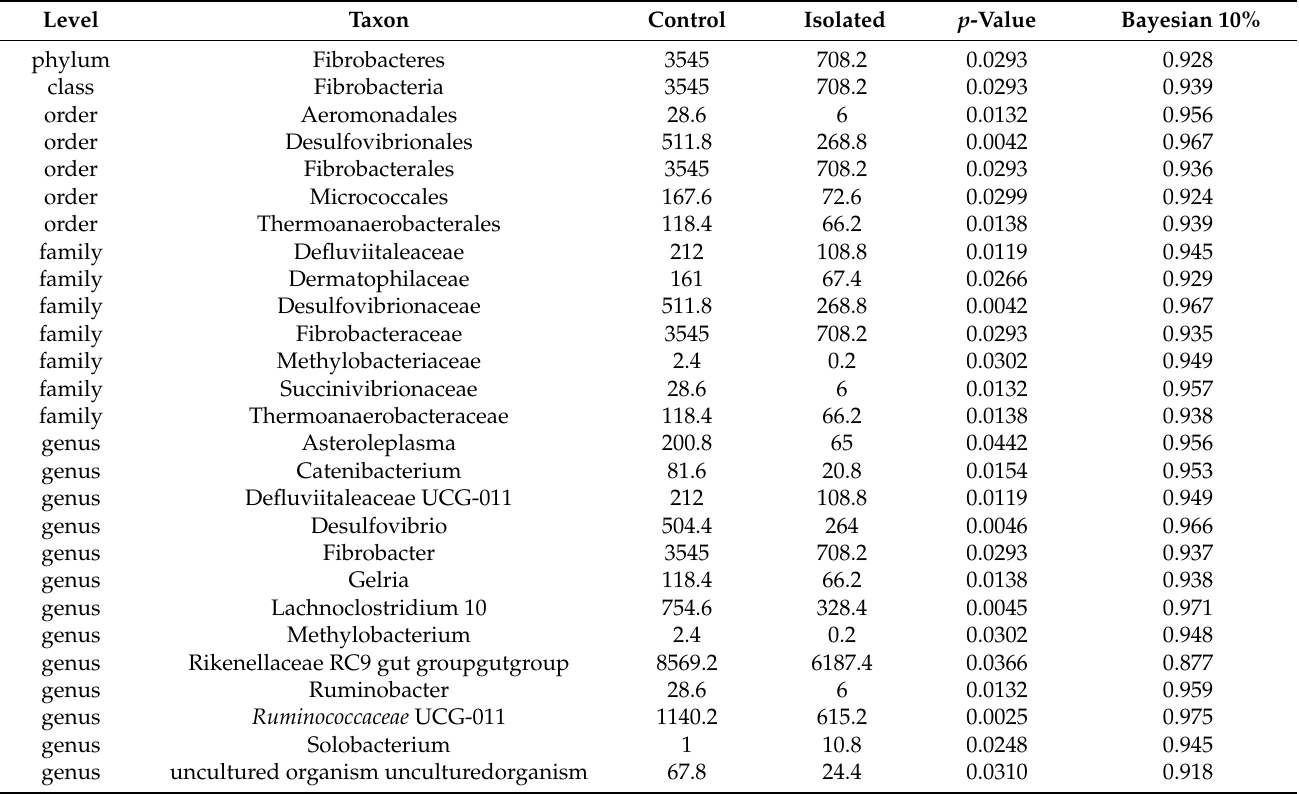
Table 3. Main taxa differences in the sheep hindgut microbiome between the two different husbandry conditions. The column Bayesian 10% reports the probability that the difference between the two groups is larger than the threshold (see material and methods section), estimated from a Bayesian model.